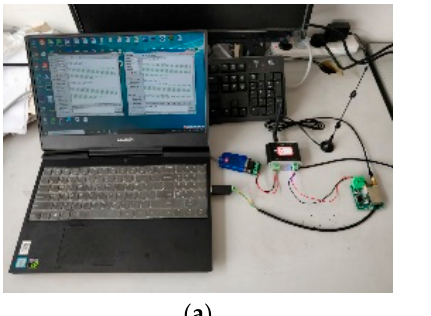
Figure 8. Equipment placement in horizontal scenario: ( a ) transmitter; ( b ) receiver; ( c ) router.